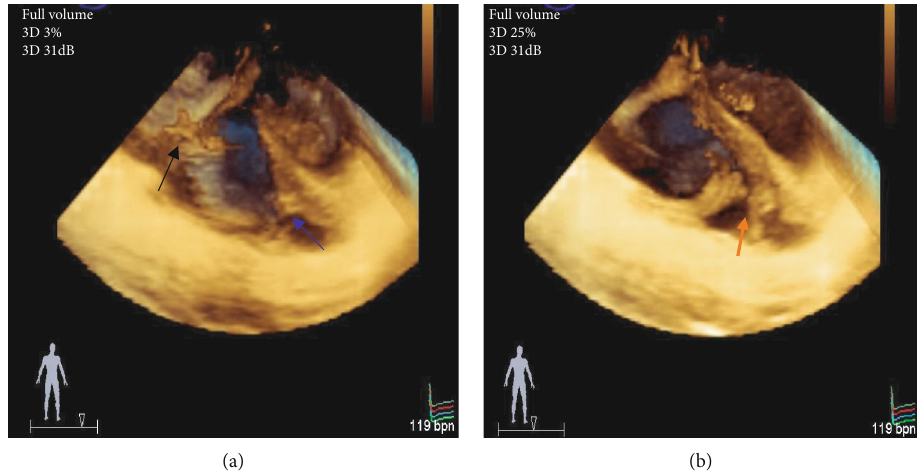
Figure 5: Three-dimensional transoesophageal views of the right ventricle showing the attachment point of the anterior papillary muscle ((a) blue and (b) orange arrows) and fl ail anterior tricuspid lea fl et with ruptured papillary muscle ((a) black arrow).